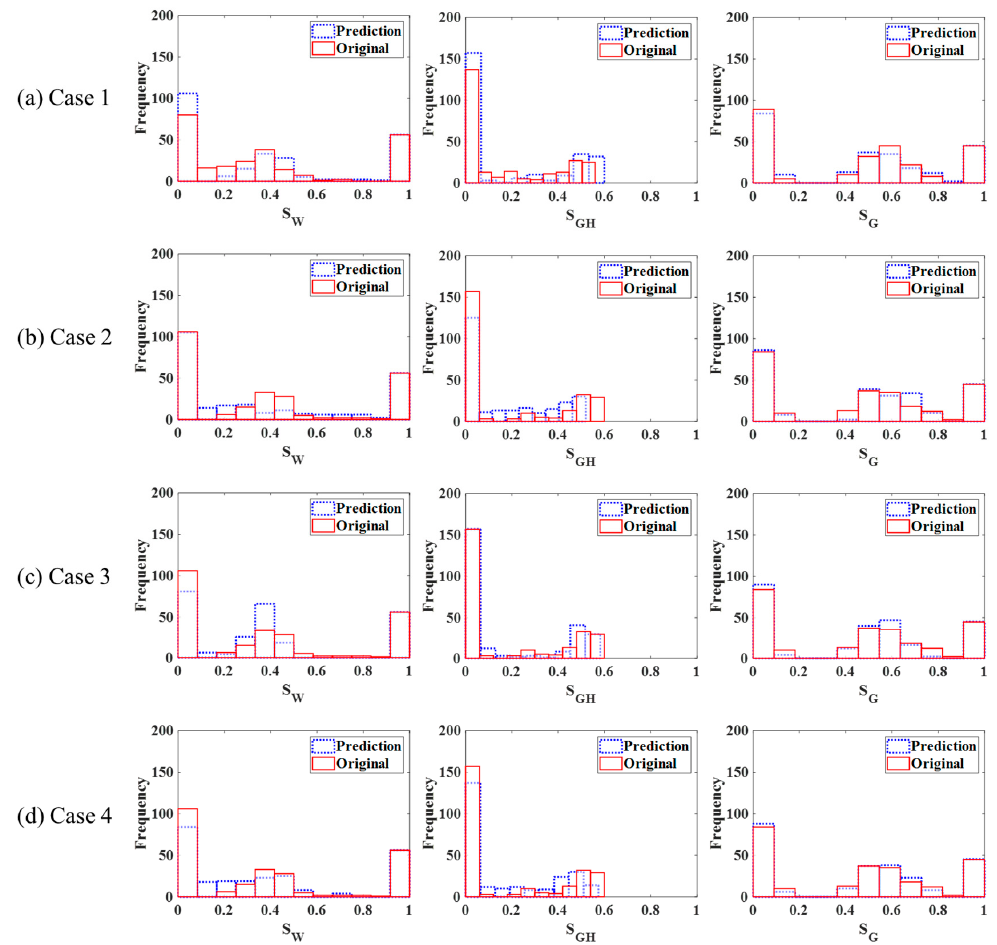
Figure 14. Universal test set results of Cases 1–4 in histogram corresponding to ( a )–( d ) in order. ( a ) Case 1 of the total eight GH samples; ( b ) Case 2 of the three low S GH samples; ( c ) Case 3 of the five high S GH samples; ( d ) Case 4 composed of the two low S GH and the two high S GH samples; each column means each saturation, water, gas hydrate, and gas with coefficient of determination; the X axis is saturation value of each phase and the Y axis indicates the frequency corresponding to saturation values. The red solid line box is the original data, and the blue dotted box is the predicted result.